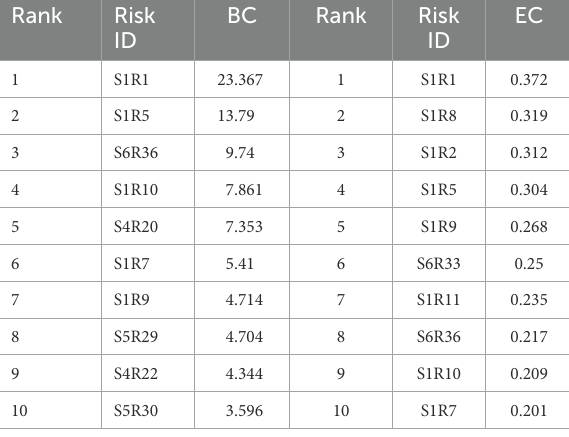
TABLE 3 Centrality of nodes in the stakeholder-risk